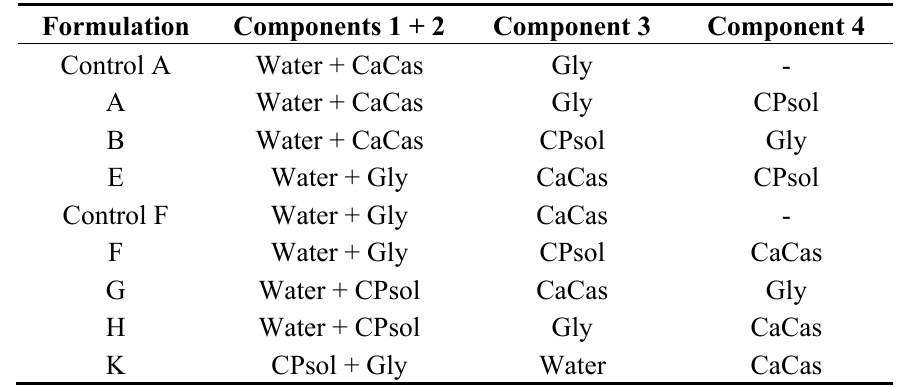
Table 1. Different formulations used for calcium-caseinate (CaCas)/glycerol (Gly)/citric pectin (CP) film solutions. CPsol, CP solution.